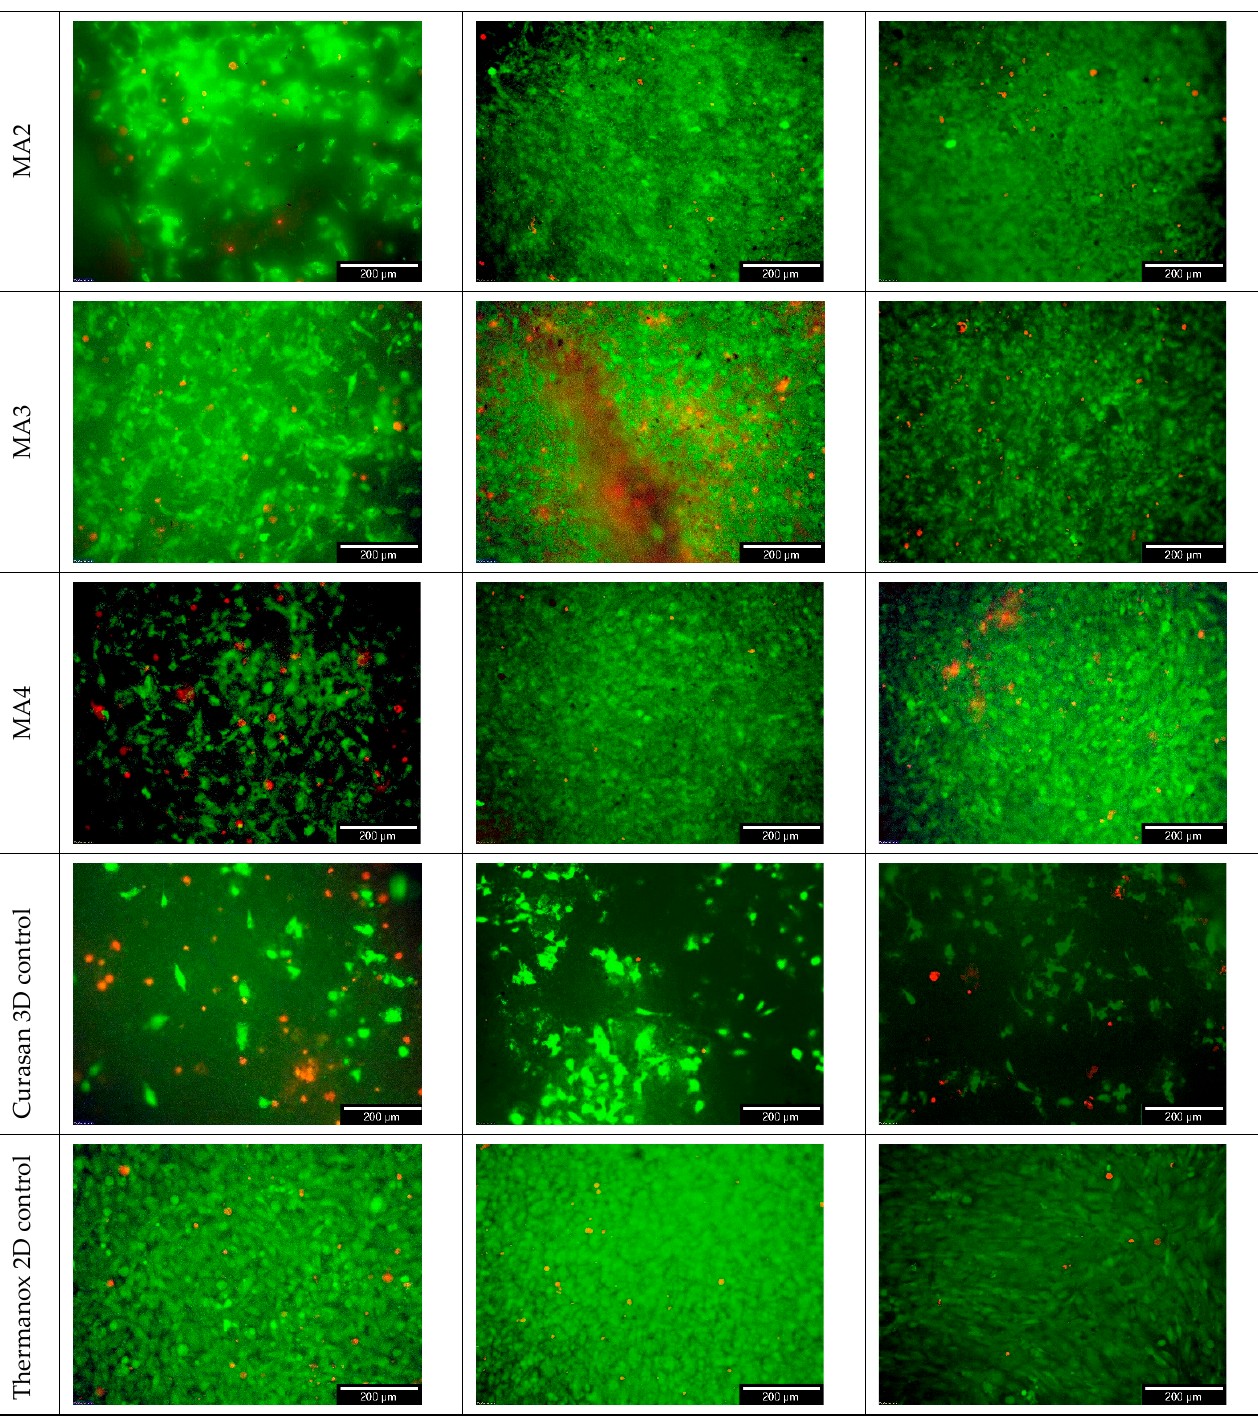
Figure 10. Live/dead staining for the different samples (including the 3D cell culture control on Curasan ceramics as well as 2D cell culture control on Thermanox cover slip). Selected samples were additionally live stained (including Hoechst), shown in Figure 11. The aim of the maximum staining was to counteract the possible intrinsic fluorescence of the ceramic. All cell nuclei glow blue.